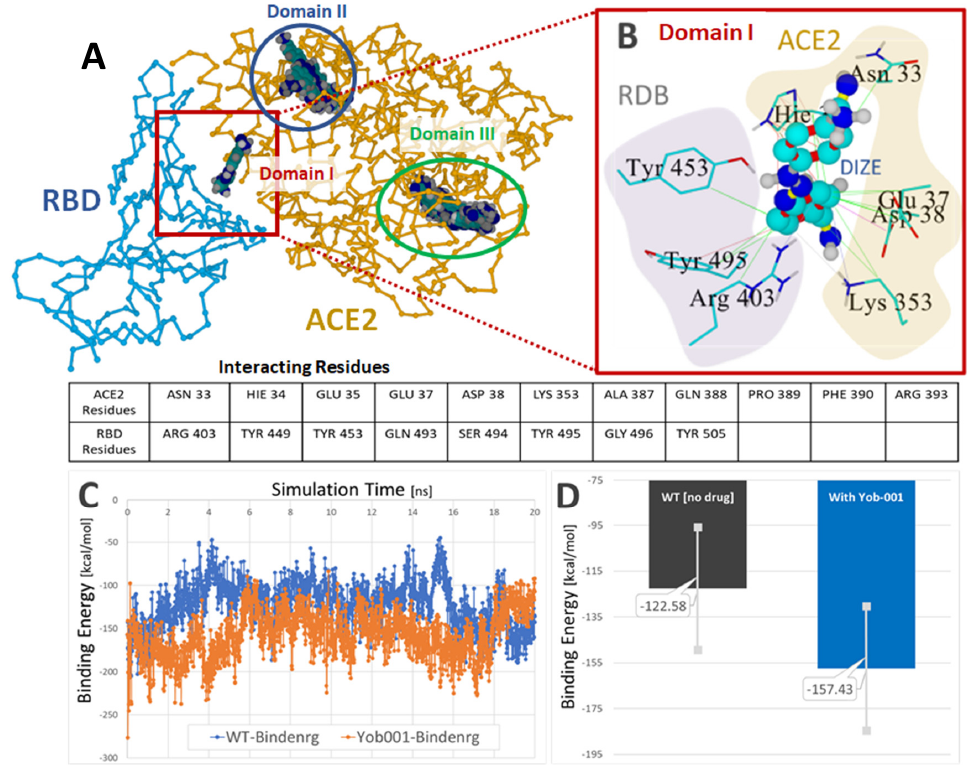
Figure 11. Global docking of DIZE (+2e charge) to the SARS-CoV-2 RBD/ACE2 complex 6LZG. ( A ) Three docking domains were identified, with DIZE positioned at the RBD–ACE interface in Domain I. The Domain I docking energy was 7.594 kcal/mol with a dissociation constant (Kd) of 2,713,464.75. ( B ) Principal interactions of DIZE in Domain I at the RBD–ACE2 interface. Hydrophobic interactions (green lines) were predominant between one aromatic ring of DIZE and RBD residues Tyr453, Tyr 495 and Arg403. Additional hydrophobic interactions for this ring involved ACE2 residues Hie34, Asn33, Glu37, Asp38 and Lys 353. Several resonant π – π interactions (red lines) involving both the RBD and ACE2 receptors helped stabilize DIZE in the interfacial pocket. ( C ) DIZE was stable in the interfacial pocket for at least 20 ns of MD simulation at 311 oK in physiological saline (0.9 wt% NaCl) at pH 7.4. ( D ) Comparison of the average RBD–ACE2-binding energies for the drug-free 6LZG complex (black bar) and the complex harboring the bound drug (blue bar) calculated over the 20-ns MD simulation. The presence of the drug resulted in a modest (approximately 34 kcal/mol) decrease in the RBD–ACE2-binding energy, suggesting DIZE may interfere with the viral attachment to susceptible host